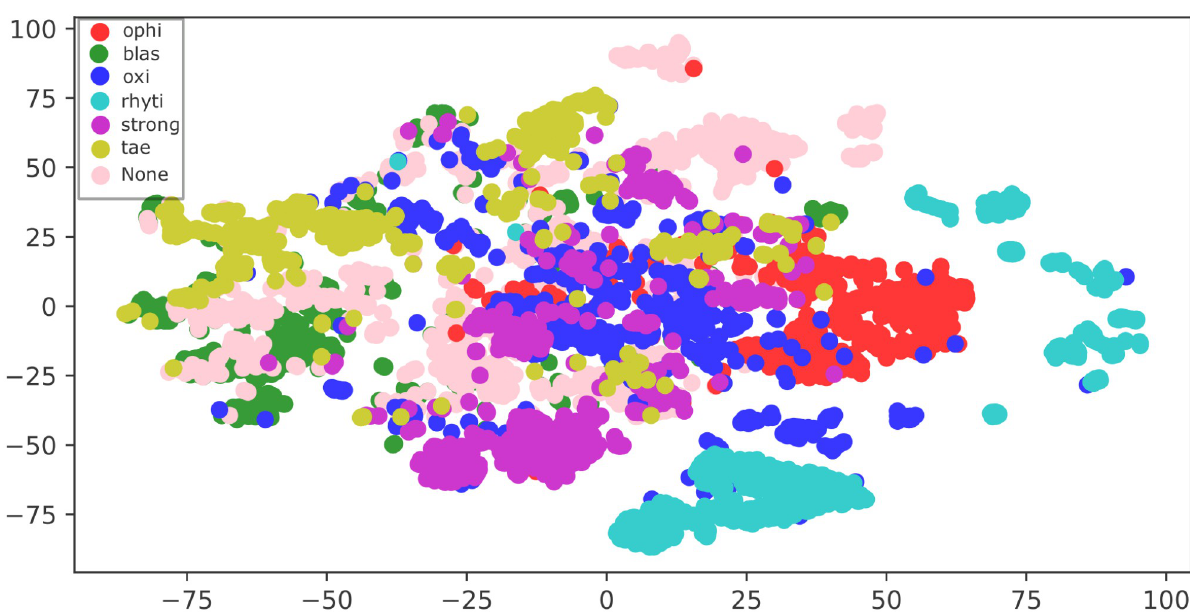
Fig 9. T-SNE plot of the multiclass model for the optimized custom net. Observe how the classes overlap far more when compared to MobileNet’s